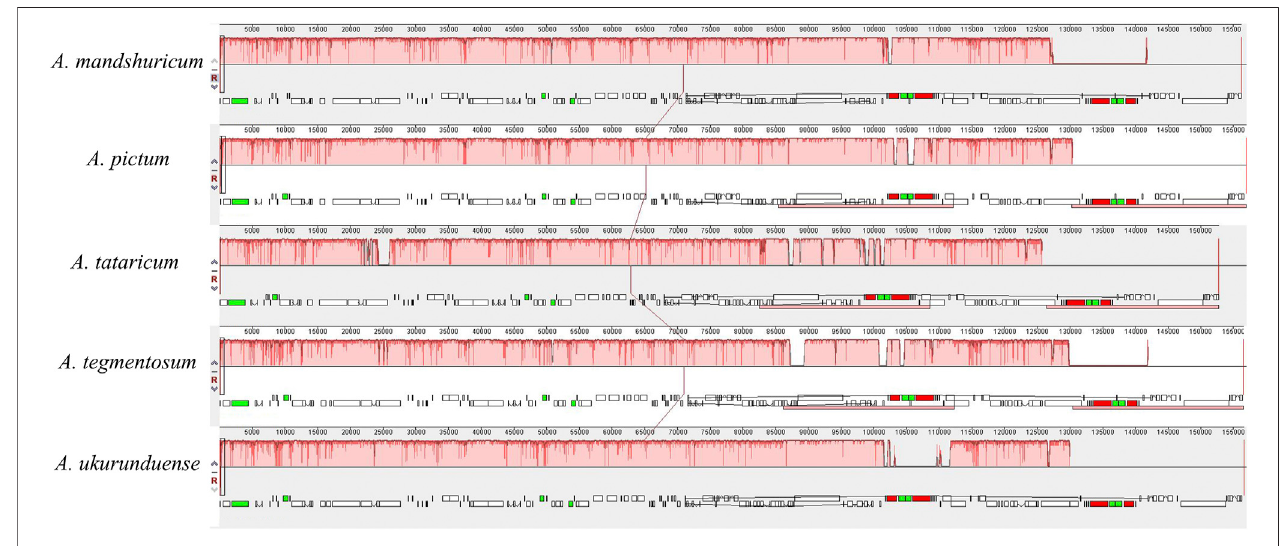
FIGURE 7 | Comparison of the genome structure of fi ve Acer species using the MAUVE